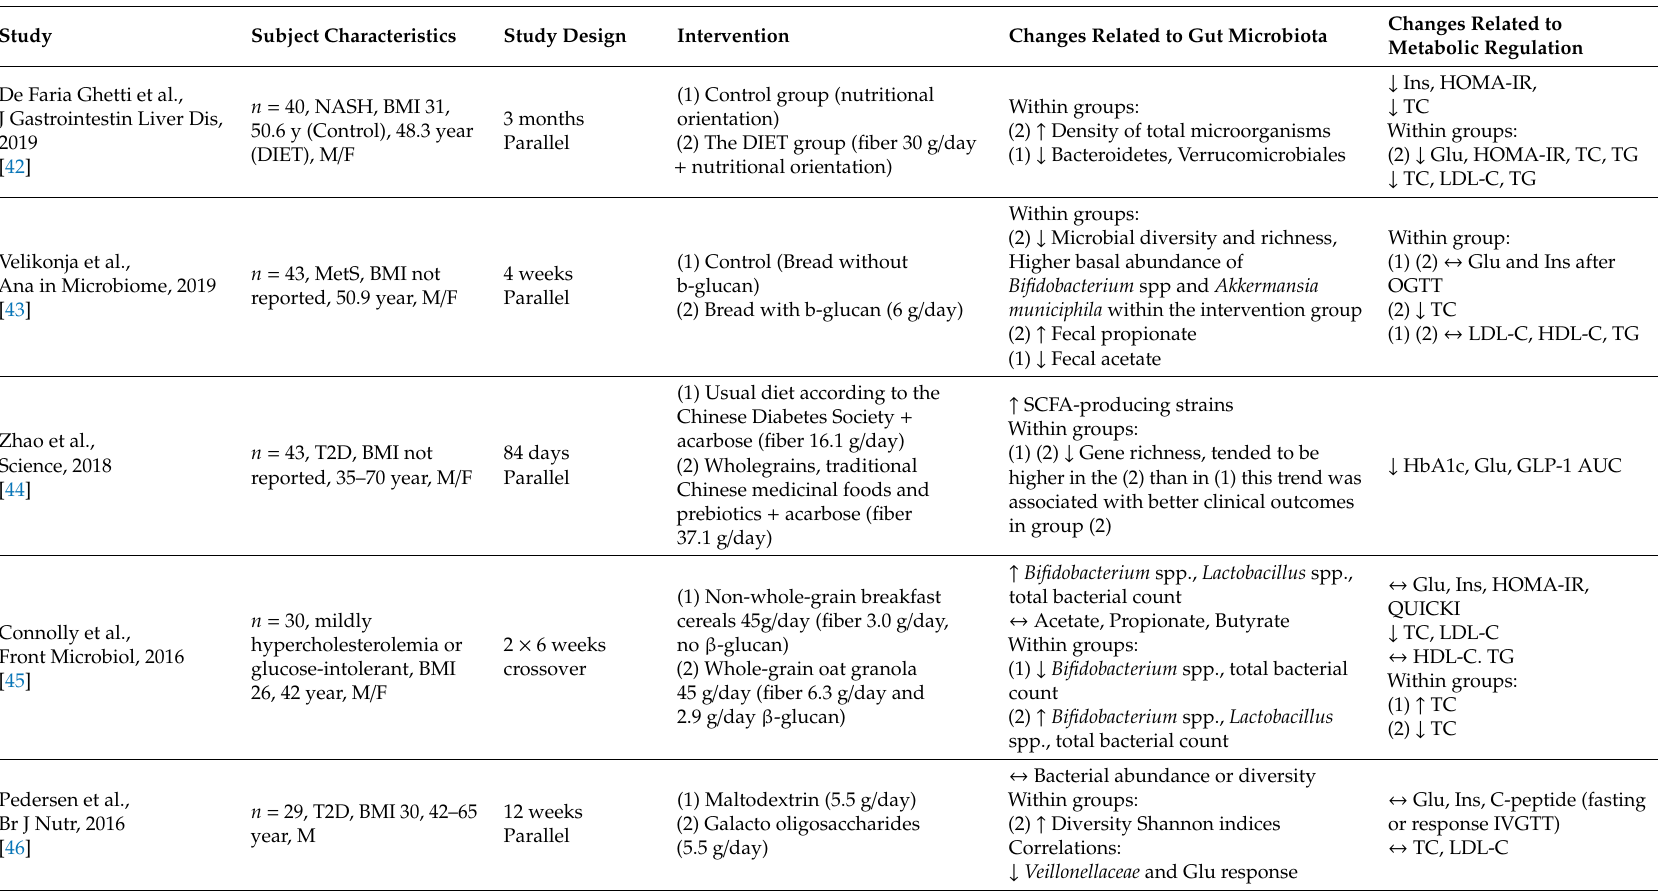
Table 4. Fiber, gut microbiota, and metabolic regulation in people with metabolism-related disorders. Significant results are indicated by an up / down